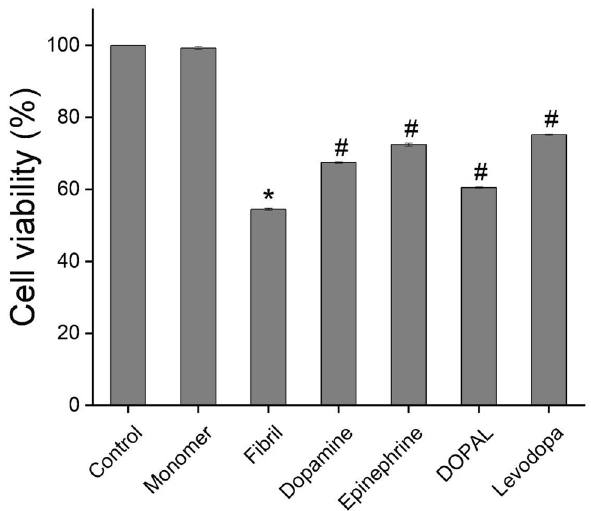
Figure 5. Cytotoxicity evaluation of α-syn aggregates (20 µM) produced in the absence or presence of 200 µM catechols. Further details relating to the experimental procedure are provided in the Materials and methods section. Data are expressed as mean ± SD with n = 5. * p < 0.001, significantly different from control cells. # p < 0.001, significantly different from cells exposed only to α-syn amyloid fibrils.